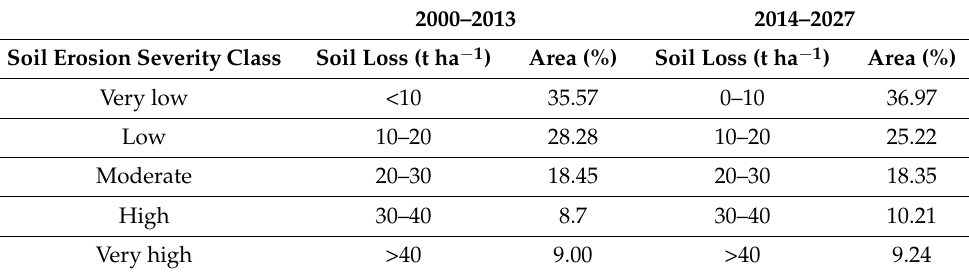
Table 8. Soil erosion rate in relation to land use using RUSLE equation.